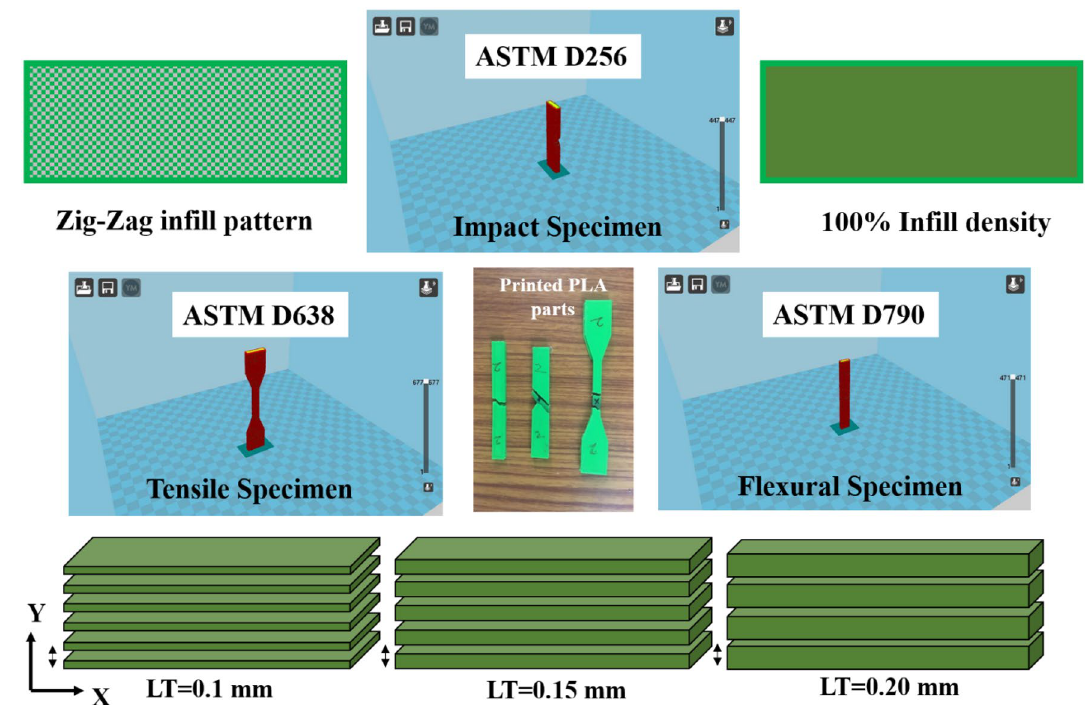
Figure 2. Schematic representation of Layer thickness, zig-zag infill pattern, 100% infill density and slicing software images of the tensile, impact and flexural specimens with printed PLA